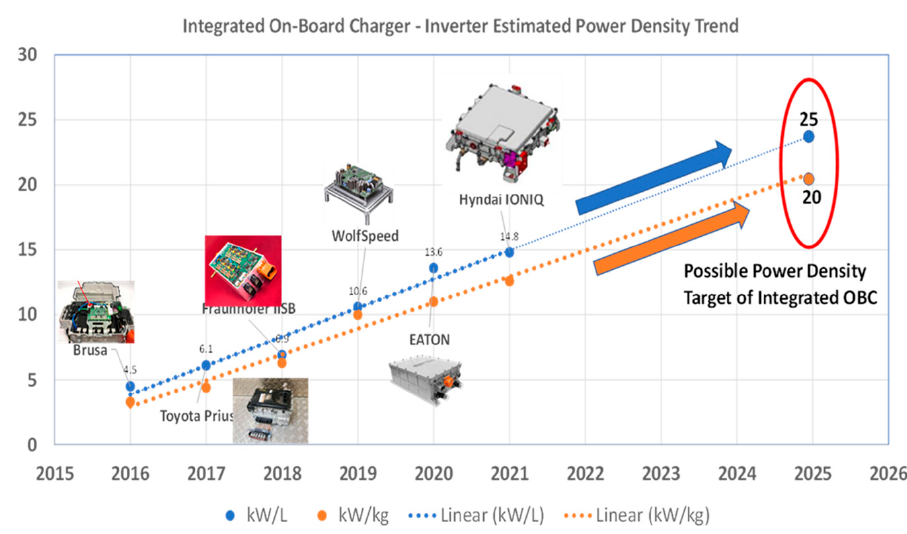
Figure 35. Estimated power density trend of integrated on-board charger (iOBC) with motor drive.